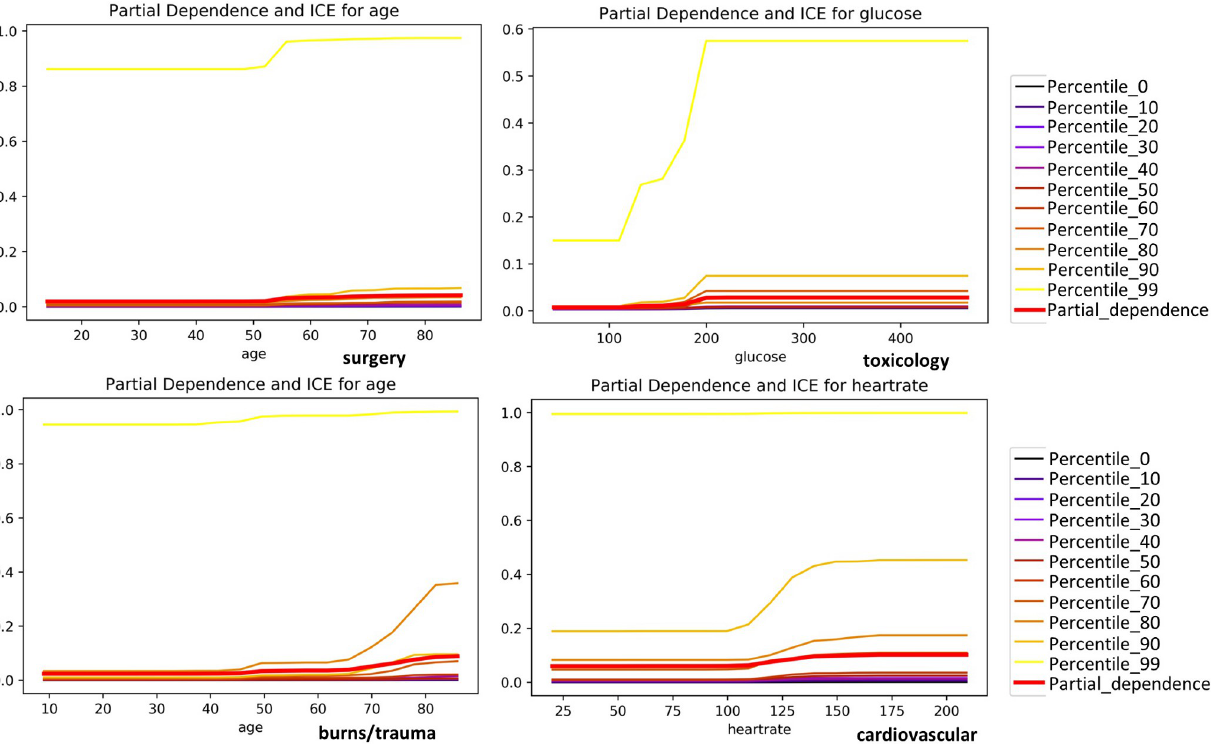
Fig 6. Partial dependence (PD) and individual conditional expectation (ICE) plots for the most important features in the prediction of ICU discharge status in surgery, toxicology, burns-trauma, and cardiovascular disease groups.